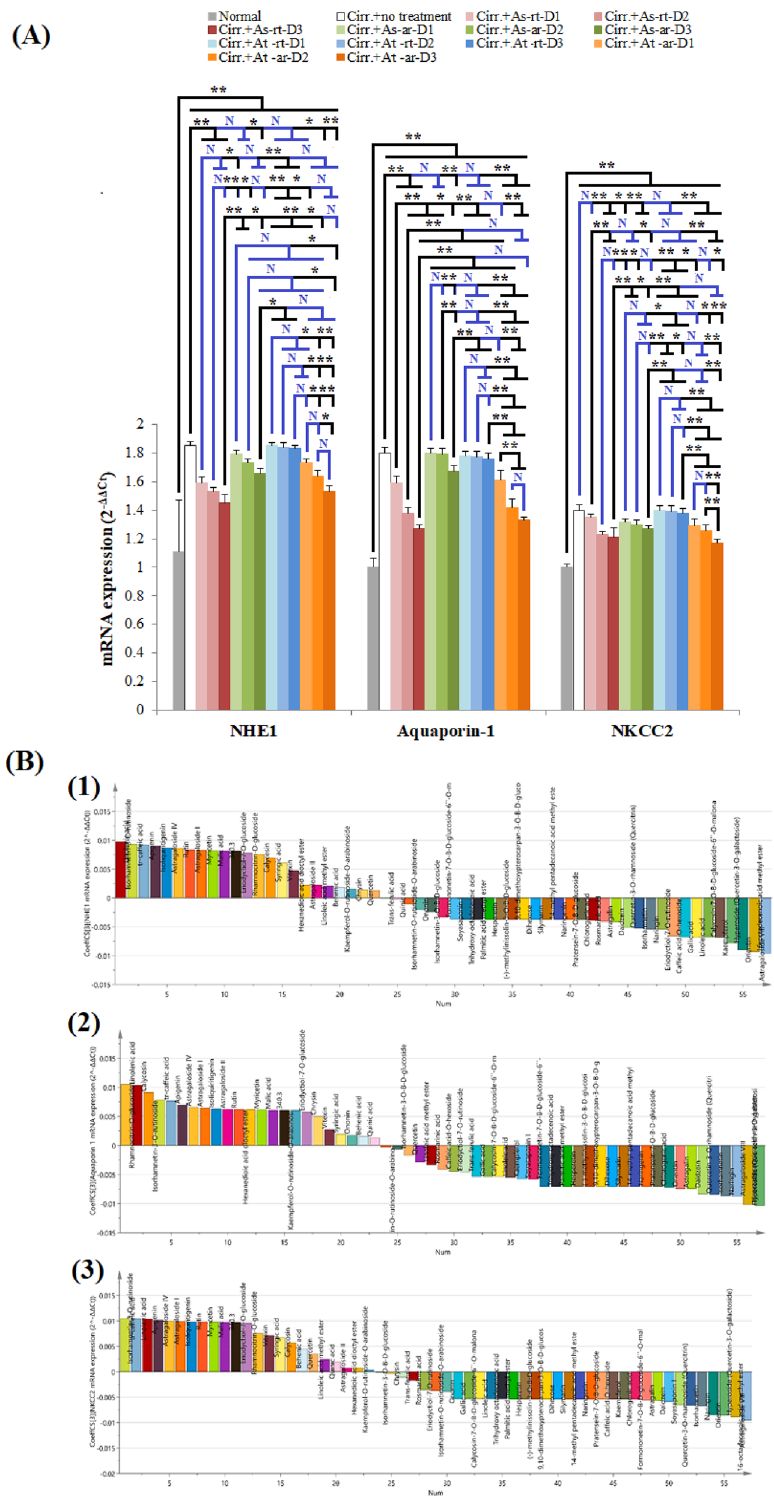
Figure 6. The effect of different Astragalus extracts on mRNA expression of proximal convoluted tubule and the thick ascending limb of the loop of Henle transporters and their coefficient plot of OPLS model. ( A ): Comparison between different groups according to mRNA expression of different renal transporters acting on proximal convoluted tubule and loope of Henle, ( B ): Coefficient plot of OPLS model for diuretic mechanisms; (1) NHE-1 (2) Aquaporin (3) NKCC2. ANOVA test was used to compare between the different groups with Post Hoc Test (Tukey) to compare different groups. *: Statistically significant at p ≤ 0.05, **: Statistically significant at p ≤ 0.001, N: Statistically non-significant ( p > 0.05), n = 8; all results are presented as mean ± SD. (Cirr.: induced cirrhosis by i.p. administration of CCl 4 (diluted 1:6 with mineral oil) as follows: The first 10 doses were received every 5 days, the subsequent 10 doses were administered every 4 days, and the last 7 doses were given every 3 days, As: Astragalus spinosus , At: Astragalus trigonus , ar: aerial organs, rt: root organs, D1: low dose, D2: medium dose, D3: high dose, NHE1: sodium–hydrogen antiporter 1, NKCC 2: Na–K–Cl co-transporter